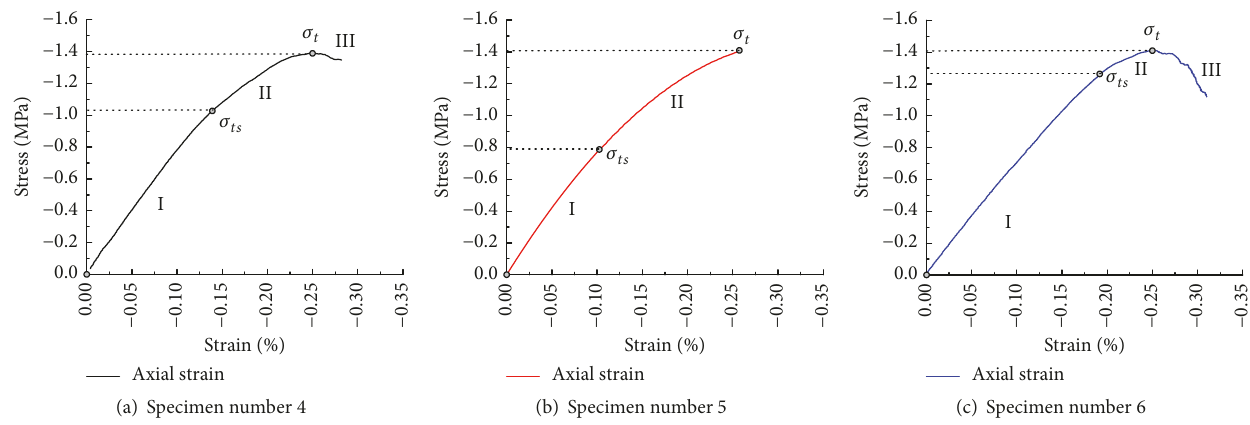
Figure 7: Typical curves of stress versus axial strain of sandstone specimens under direct